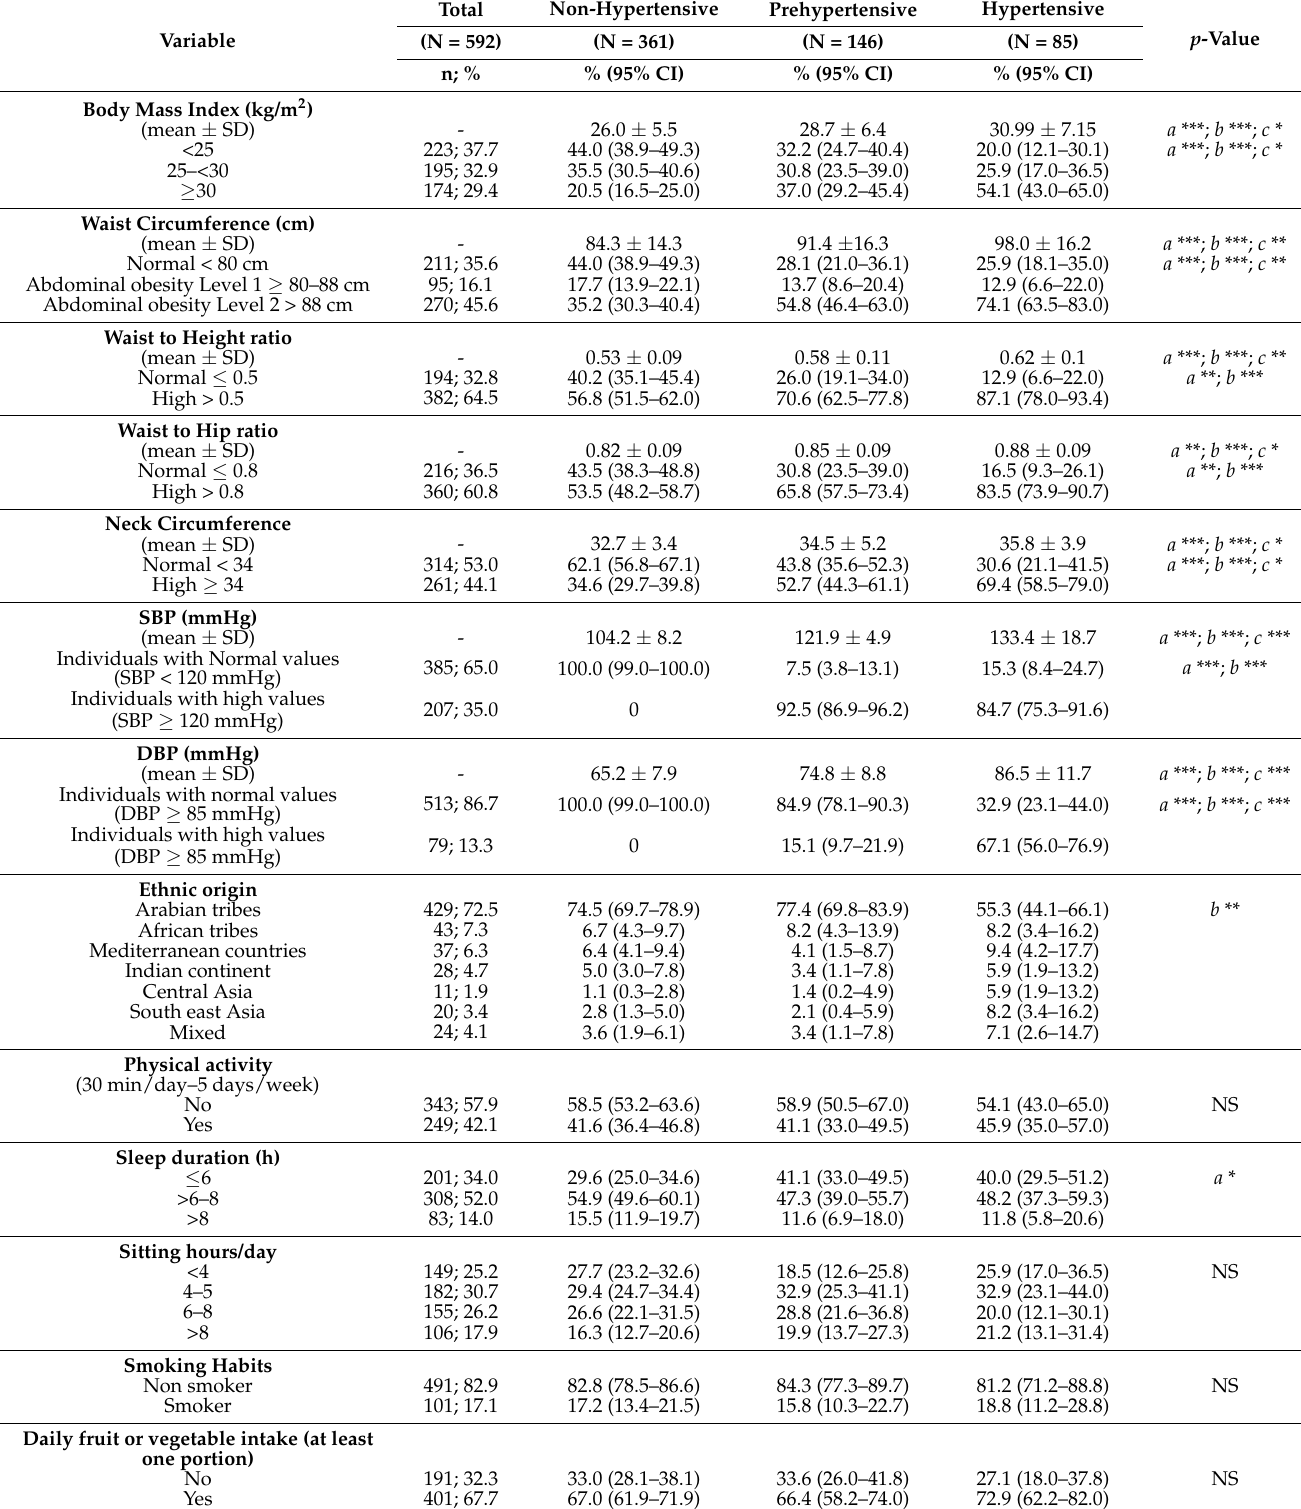
Table 3. Association between demographic, lifestyle, vital signs, and anthropometric characteristics with prehypertension and hypertension in the female